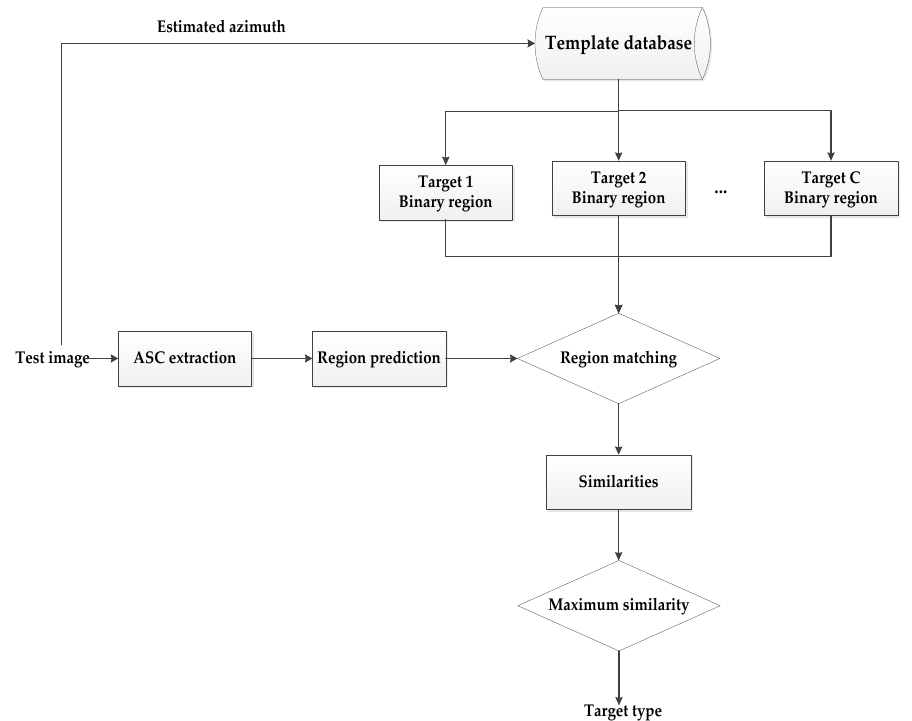
Figure 7. The basic procedure of target recognition.